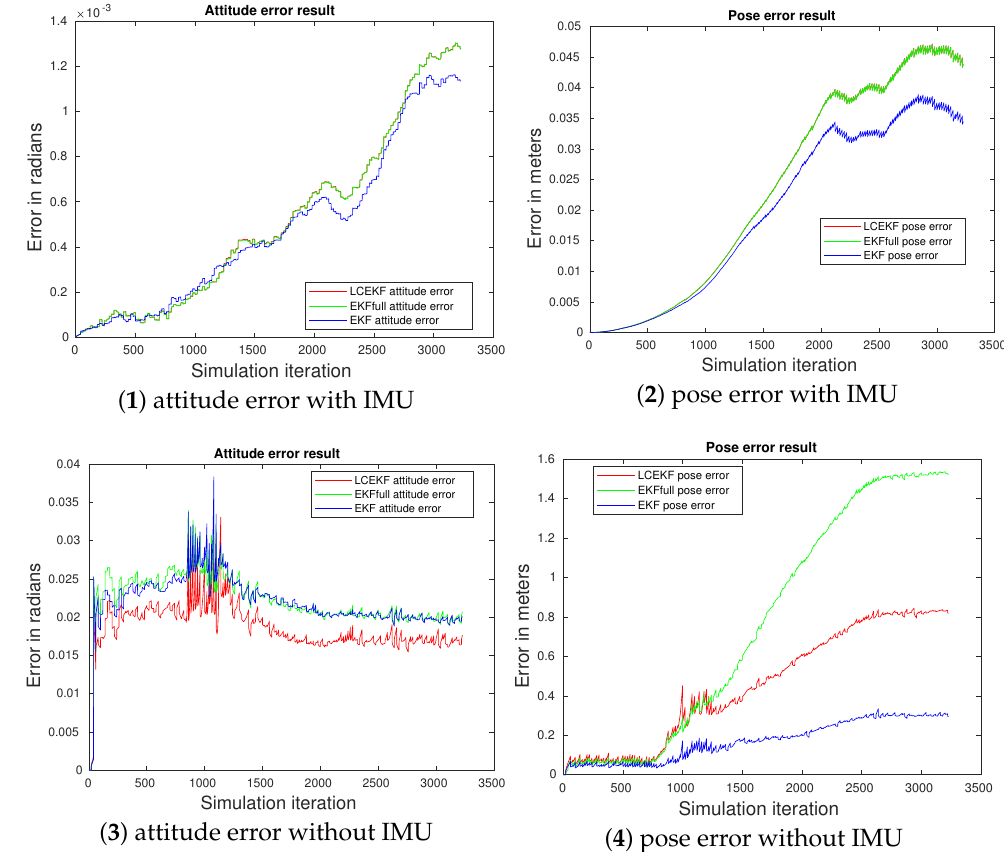
Figure 11. SLAM with no noise (Case i): methods’ comparison. Figures ( 1 ) and ( 2 ) represent the MSE of the pose and attitude estimation over 10 executions for the three methods while using the IMU for prediction. All the methods performed in the same way. Figures ( 3 ) and ( 4 ) represent the MSE of the pose and attitude estimation over 10 executions for the three methods while using a constant velocity model for prediction (no proprioceptive sensor). It can be seen that without the use of the IMU, both the LCEKF and EKFfull had a positioning error that increased over time (classical observed